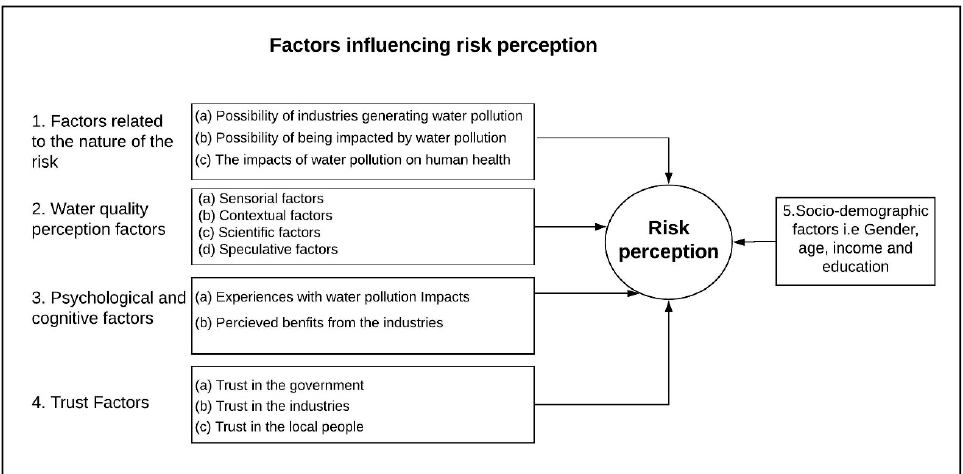
Figure 1. Conceptual framework of the present study.